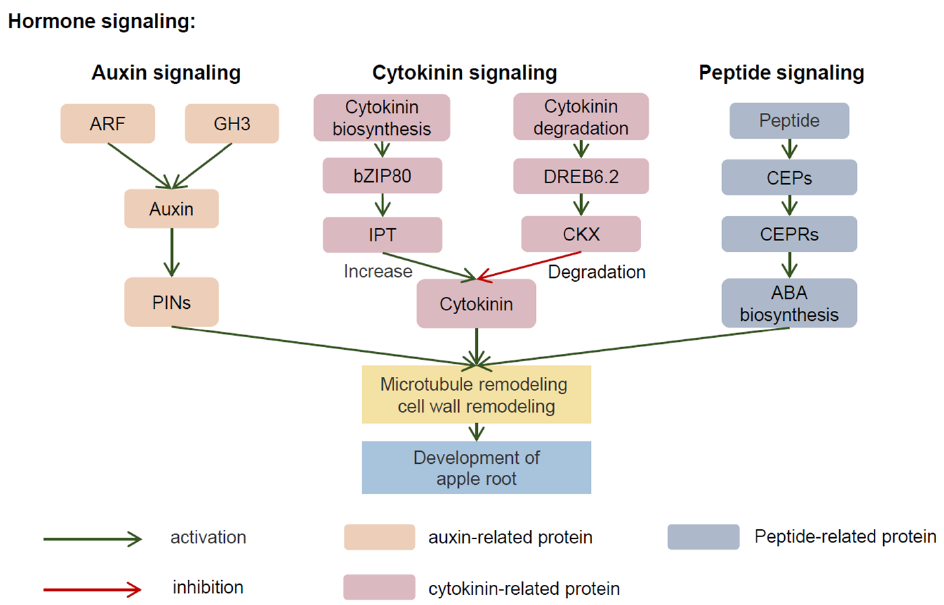
Figure 3. The phases of the mechanism regulating the root system configuration. The signaling component is activated by hormones. In apple, ARF and GH3 are involved in the synthesis of auxin, and the efflux of auxin is inseparable from PINs. CK levels are maintained mainly by CK biosynthesis (isopentenyl transferase, IPT) and degradation (cytokinin dehydrogenase, CKX) genes. Some CLEs have the ability to promote ABA synthesis, which is transferred from the root long distance to the leaves to bind receptor proteins, resulting in an increased ABA concentration and participation in the appropriate function. ARF: auxin response factor; GH3: Gretchen Hagen 3; PINs: PIN-FORMED (PIN) auxin transporters; bZIP80: Basic region/leucine zipper motif 80; IPT: isopentenyl transferase; CKX: cytokinin dehydrogenase; CEPs: C-TERMINALLY ENCODED PEPTIDE; CEPRs: CEP receptors; ABA: abscisic acid.